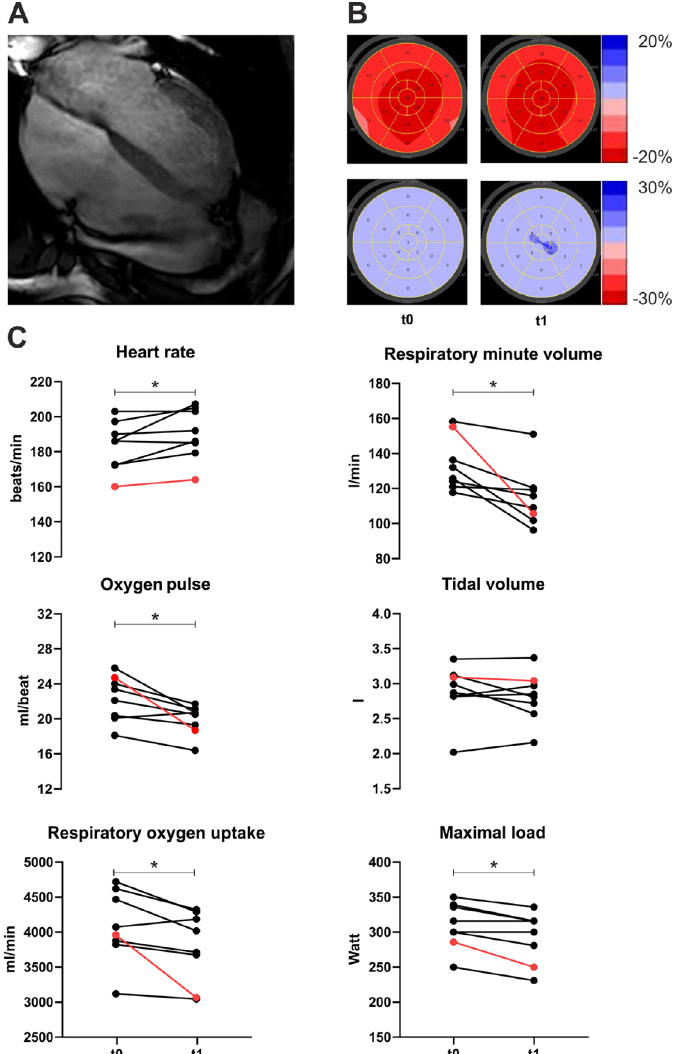
2020 t1: post-SARS-CoV-2 infection (COVID-19) in winter 2020 of athletes with a history of SARS-CoV-2 infection. ( A ) cardiac resonance imaging of athlete with pericardial effusion. ( B ) longitudinal strain (red) and post systolic shortening index (blue) at t0 and t1. ( C ) key spiroergometric parameters at maximal load. The athlete with the highest T1-mapping values in magnetic resonance imaging and with pericardial effusion during the infection is highlighted in red. *: p <